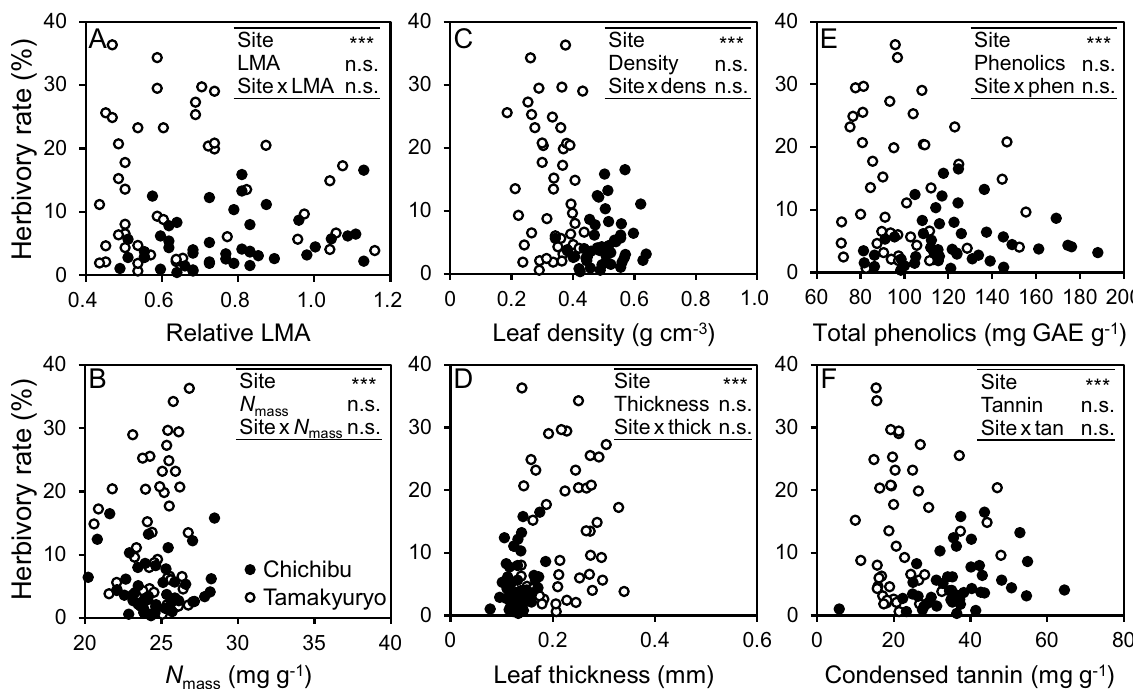
Figure 5. The value of herbivory rate as a function of ( a ) relative LMA, ( b ) N mass , ( c ) leaf density, ( d ) leaf thickness, ( e ) total phenolics, and ( f ) condensed tannin of Q. serrata grown in FM Tamakyuryo in July 2018 (while circle) and FM Chichibu in August 2018 (black circle) (n = 45). * p < 0.05, *** p < 0.001, n.s., not